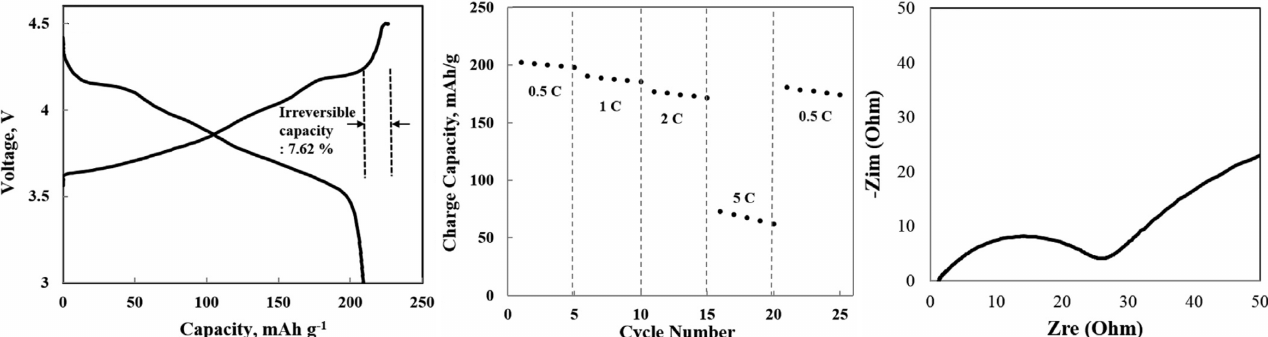
Figure 17. Charge/discharge curves, rate capacity, and initial Nyquist plot for porosity controlled LiNi 0.91 Co 0.06 Mn 0.03 O 2 NMC. Reproduced with permission